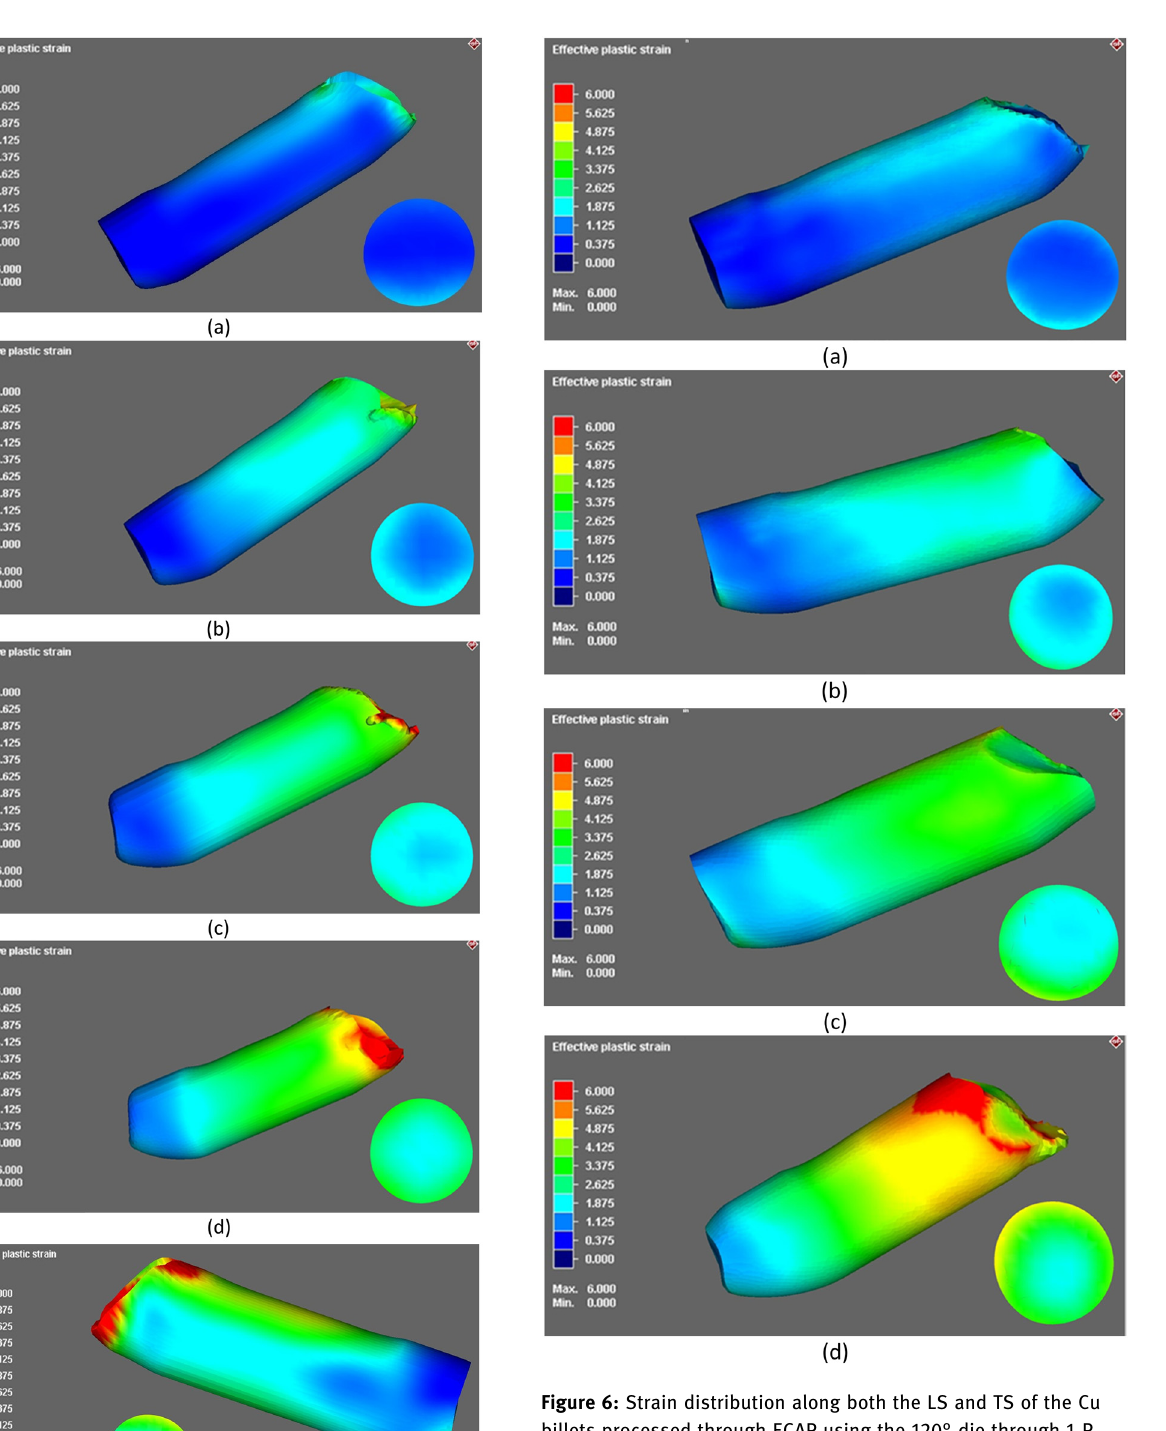
3 - Bc condition at RT, the strain increased to 1.875 and 3.375 at the central and peripheral areas of the LS, respec - tively whereas the central regions of the TS recorded a strain of 1.875 which dominated the strain distribution